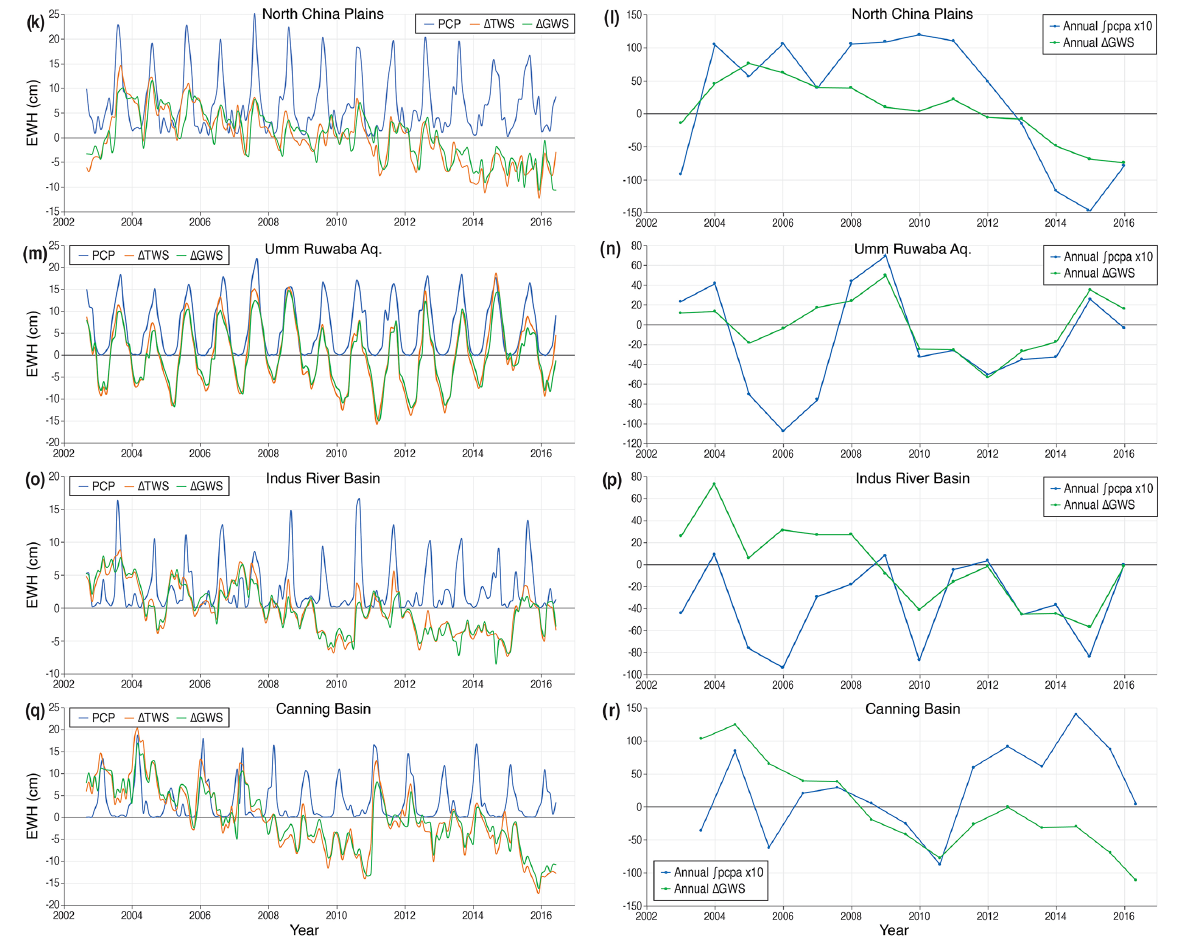
(cid:82) PCPA time series for each of the dryland climate zone aquifer Figure 2. Monthly (cid:49) TWS and (cid:49) GWS vs. PCP and annual (cid:49) GWS vs. systems, as labelled. Systems are ordered by decreasing PCC for annual (cid:49) GWS vs. (cid:82) PCPA. All time series are plotted to the aquifer system lag as set out in Table 3, where (cid:49) TWS ( (cid:49) GWS) lags PCP (PCPA) by the specified number of months. Y -axis units are equivalent water height (EWH) in centimetres. Note the variation in the y -axis scales. Seven of the annual (cid:82) PCPA data series have been scaled by a factor of 10 for clarity where